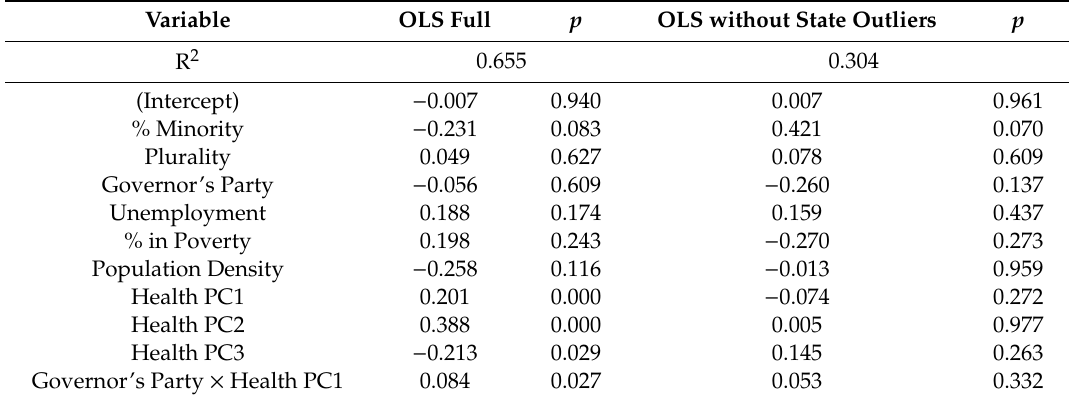
Table 6. Results of the regression analyses for the state